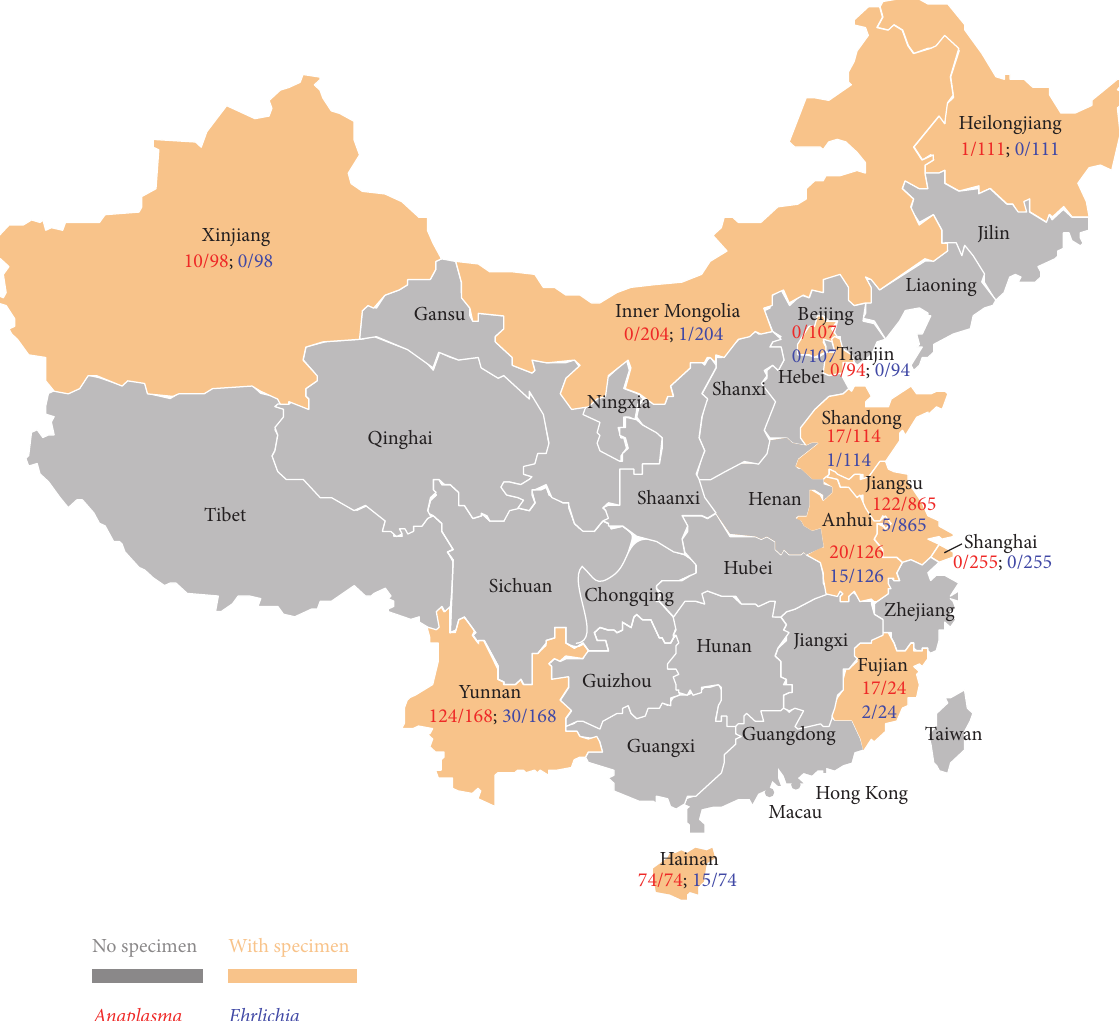
Figure 1: Detection of Anaplasma spp. and Ehrlichia spp. in ruminants from 12 provinces of China. Blood samples of ruminants (2,240) were collected from twelve provinces (in bisque) of China. The prevalence is shown for Anaplasma spp. (red) and Ehrlichia spp.